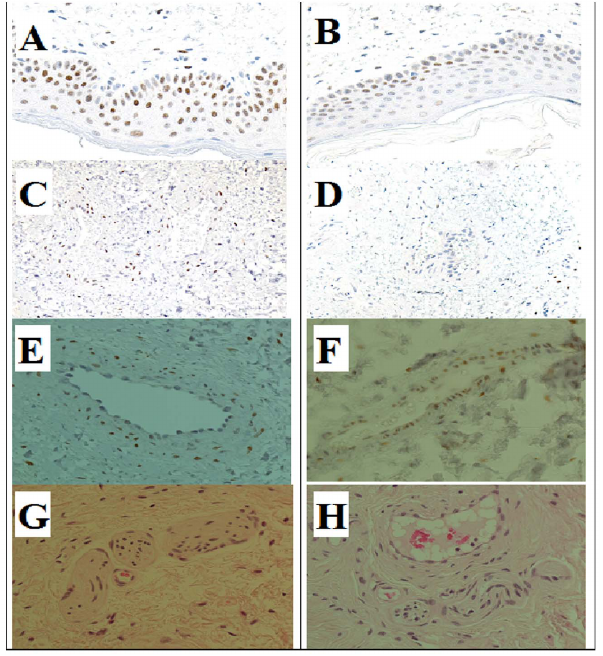
Figure 1. AR positive cells (by brown staining): (A) case, (B) control in epithelial cells; (C) case, (D) control in stromal cells; (E) case, (F) control in vessels smooth muscle cells. Nerves in foreskin tissue from a case (G) and a control (H).